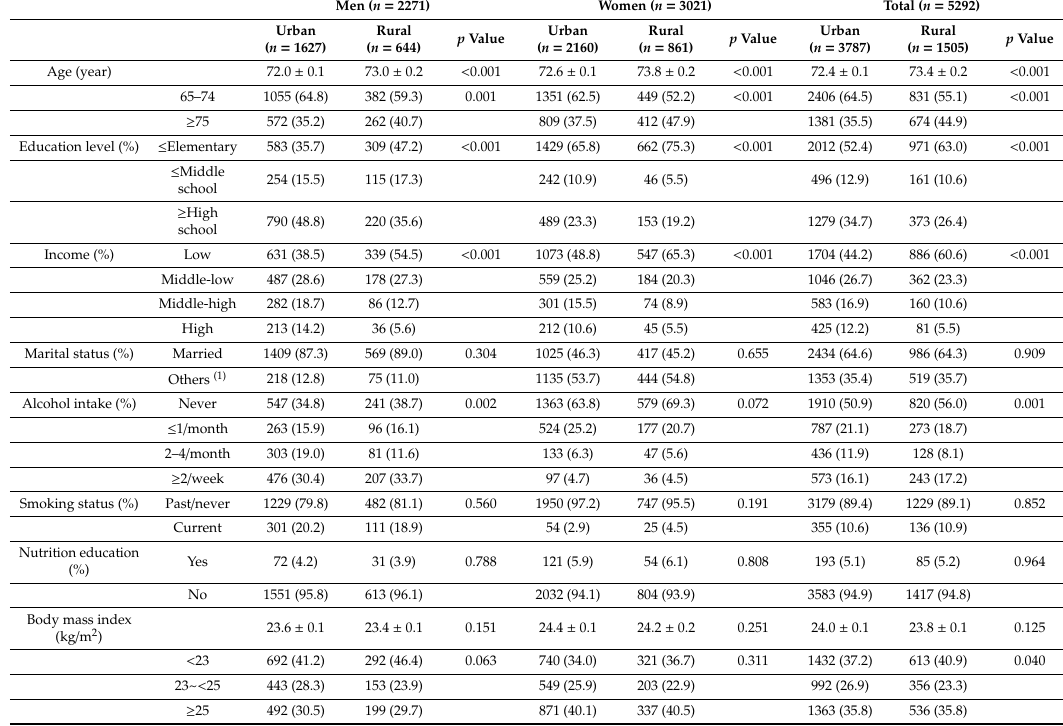
Data represent mean ± standard error or number of case (%). Categorical variables were analyzed using the Chi-square test. Continuing variables were analyzed using the general linear model. Total data was additionally adjusted for sex using Chi-square test for categorical variables and general linear model for continuous variables. (1) Widowed, separated, divorced, or never